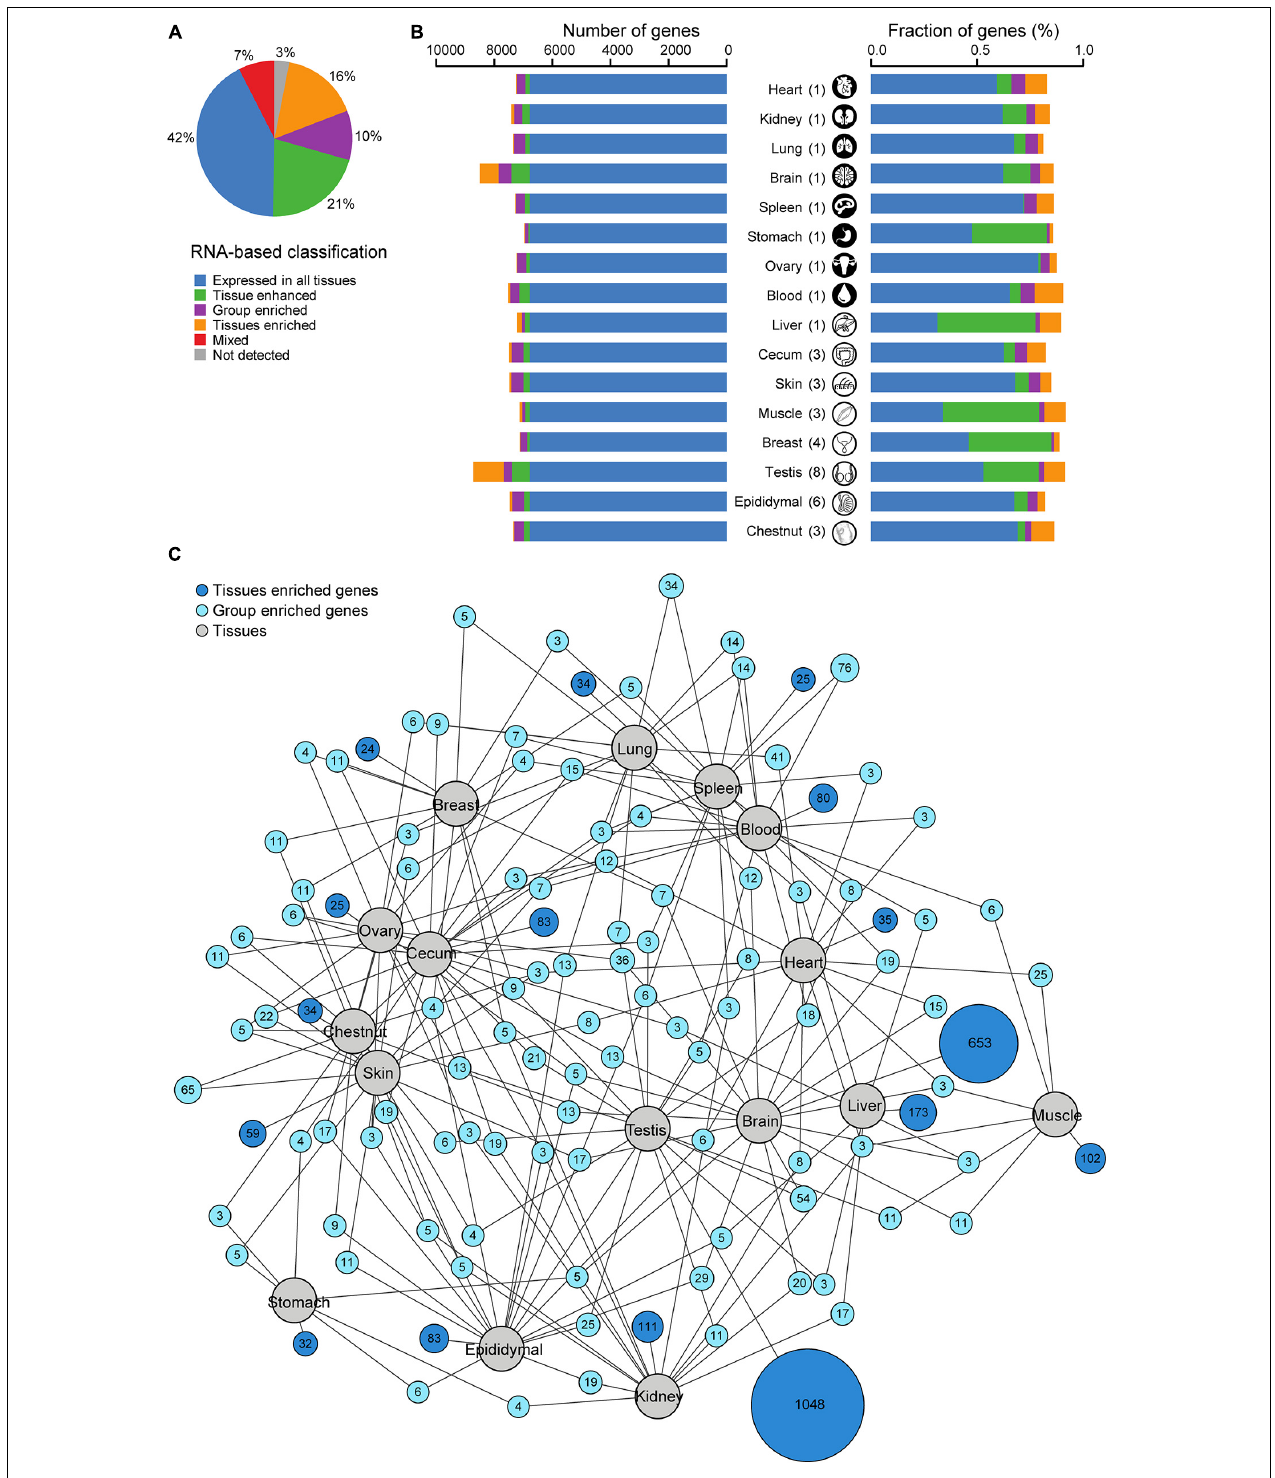
FIGURE 2 | Classification of all donkey protein-coding genes with regards to the transcriptional levels in 16 tissues. (A) Pie chart showing the distribution of all 16,013 genes into six different categories based on the transcript abundance (fragments per kilobase million, FPKM). (B) Number and fraction of genes detected on the mRNA level in each tissue. FPKM was used as a measure of gene expression. The colors are the same as in panel (A) . (C) Network plot showing the relationship of tissue enriched and group enriched genes in various tissues and organs analyzed. Blue circle nodes represent a group of expressed genes and are connected to tissues represented by gray circles. Dark blue nodes show the number of group-enriched genes in up to five different tissue types (gray circles), with a minimum of three genes. Light blue nodes show the total number of tissue-enriched genes in each tissue. The size of each blue node represents the square root of the number of genes enriched in a particular combination of tissues. FPKM was used as a measure of gene